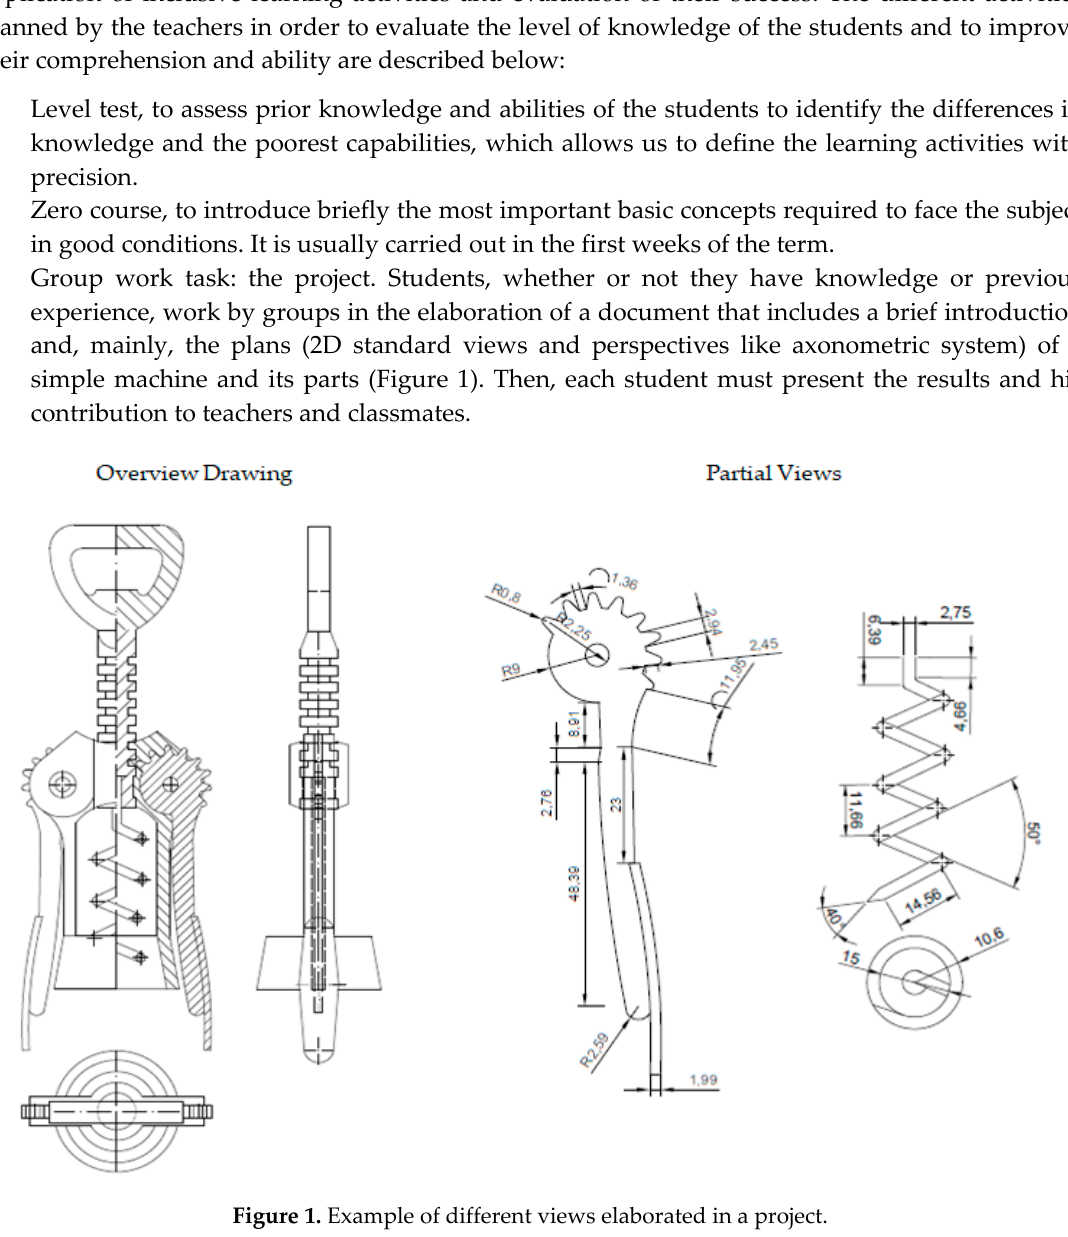
Figure 1. Example of different views elaborated in a